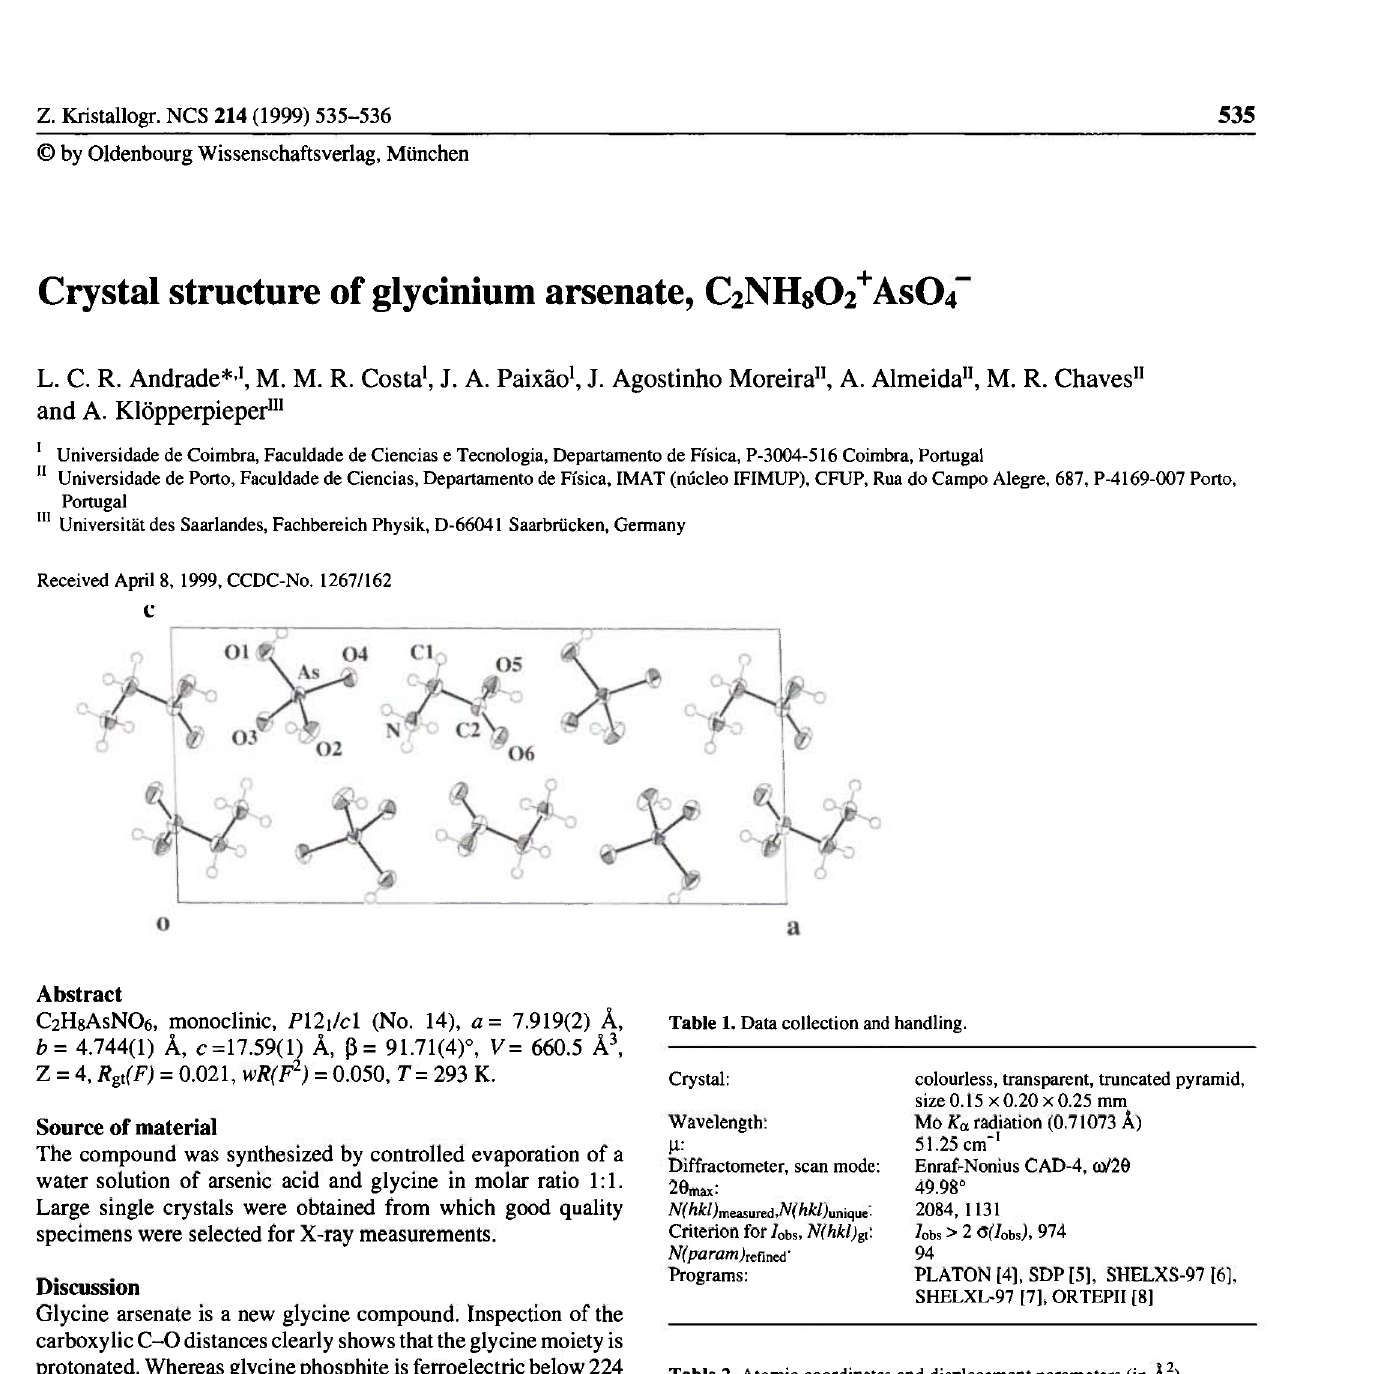
Table 2. Atomic coordinates and displacement parameters (in Ä 2